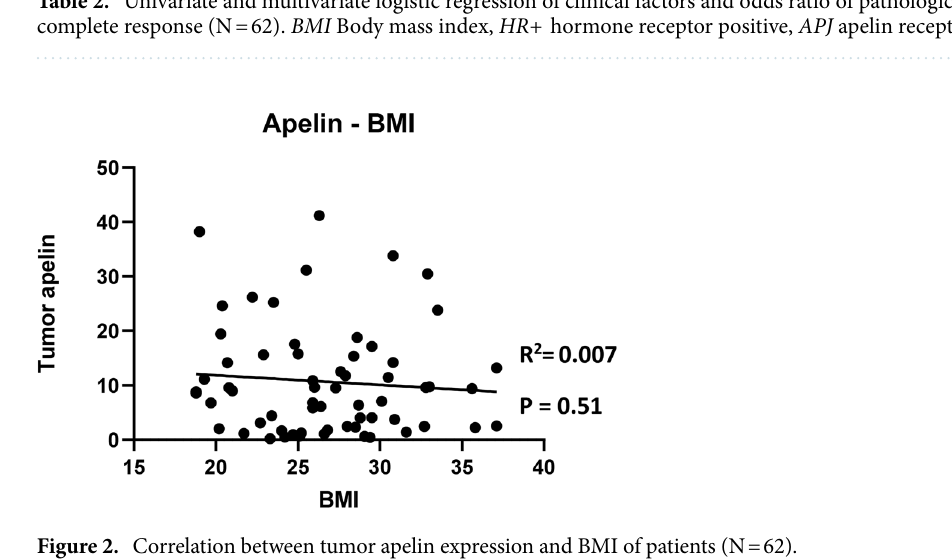
Table 2. Univariate and multivariate logistic regression of clinical factors and odds ratio of pathological complete response (N = 62). BMI Body mass index, HR+ hormone receptor positive, APJ apelin receptor .